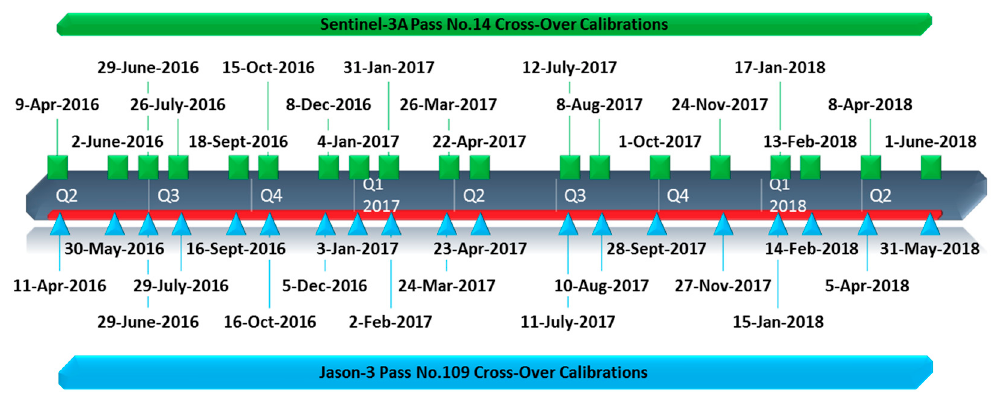
Figure 14. Dates when Sentinel-3A Pass No.14 and Jason-3 Pass No.109 overpassed the cross-over location south of Gavdos within a window of ±3 days.